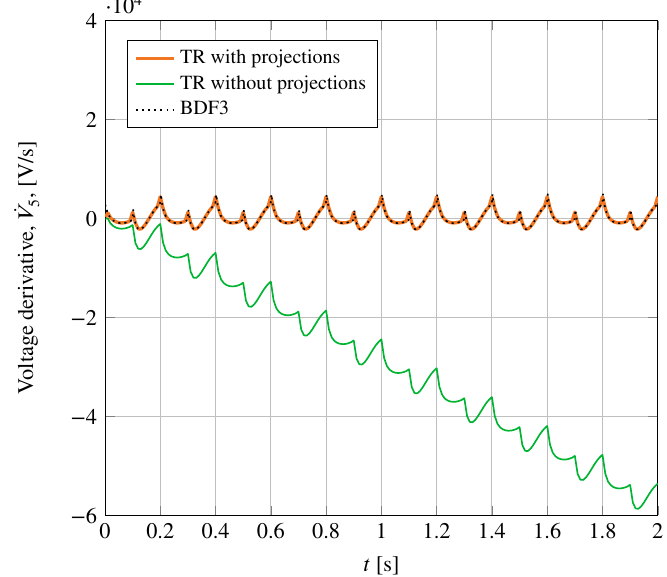
Figure 12. Full wave rectifier: Derivative with respect to time of the voltage at node 5, ˙ V 5 .